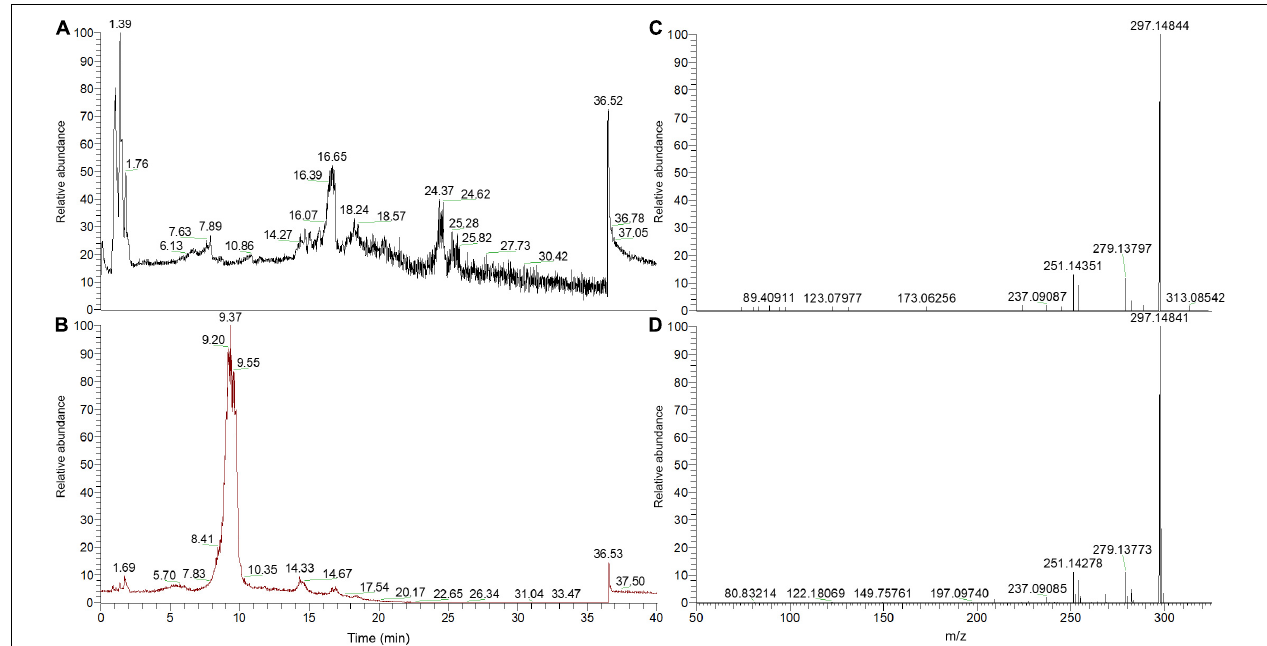
FIGURE 1 | Cryptotanshinone detection with high-resolution mass spectrometry. Penicillium murcianum extracts were compared to a 50 ppm cryptotanshinone standard. (A,B) Total ion chromatograms of the Penicillium murcianum extract and the cryptotanshinone standard, respectively. (C,D) High-resolution MS2 product ions of the Penicillium murcianum extract and the cryptotanshinone standard, respectively. The chromatograms and high-resolution MS2 product ion spectra of the other isolates are included as Supplementary Figures S2, S3 ).